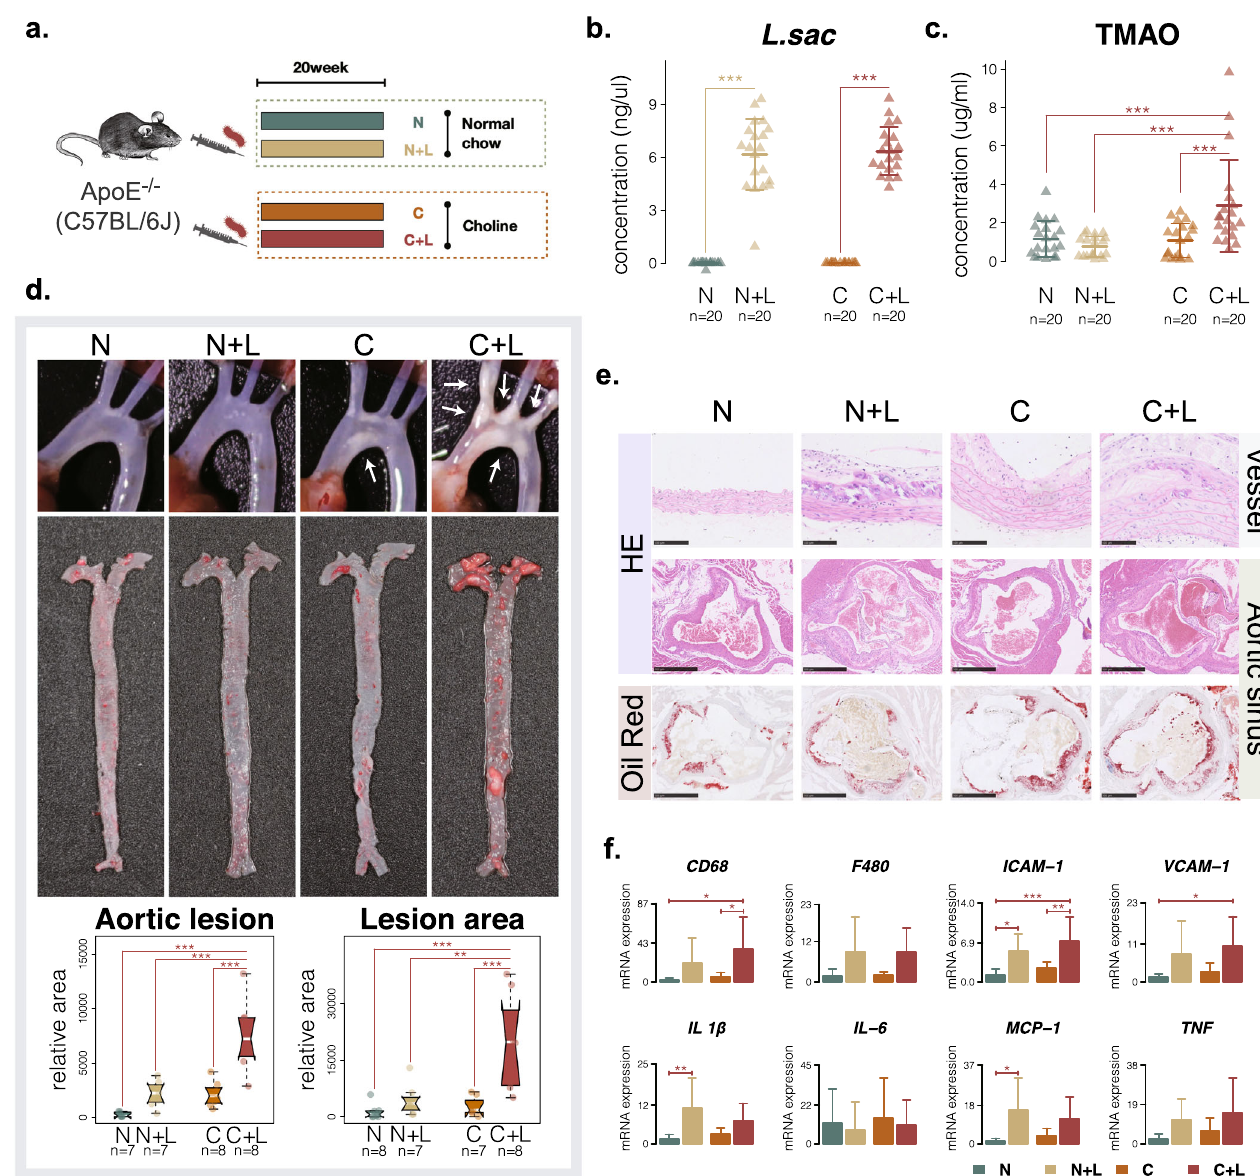
Fig. 5 L. saccharolyticum increased TMAO level and accelerated atherosclerosis in ApoE − / − mice. a Schematic diagram of the animal experiments. b The concentration of L. saccharolyticum in fecal samples of the four groups ( n = 20). c The serum levels of TMAO in the four groups ( n = 20). d Atherosclerotic plaques of mice are shown in pictures, and the quantitative results of the plaque area are shown in the box plot ( n = 7 or 8). The bounds denote the interquartile range between the fi rst and third quartiles and the center line denotes the median. The whiskers denote the lowest and highest values. e Staining results of tissue sections. The upper panel shows the HE results of vessel tissue, the middle panel shows the HE results of aortic sinus, and the lower panel shows the Oil Red results of aortic sinus. The scale bars of vessels denote the 100 μ m, and the scale bars of aortic sinus denote the 500 μ m. f The mRNA expression of related cytokines in vascular endothelial cell tissue ( n = 8). Error bars denote the means ± s.e.m. * p < 0.05, ** p < 0.01, *** p < 0.001, the differences among groups were analyzed by single-factor ANOVA corrected with Tukey HSD test. N: normal group, mice fed with standard chow control diet and gavaged with the sterile medium; N + L: normal + L. saccharolyticum group, mice fed standard chow and gavaged live L. saccharolyticum at a dose of 5 × 10 8 CFUs/ 100 μ l; C: choline group, mice fed with standard chow supplemented with 1.0% choline (Sigma-Aldrich, USA) and gavaged with the sterile medium; C + L: choline + L. saccharolyticum group, mice fed with standard chow supplemented with 1.0% choline and gavaged with